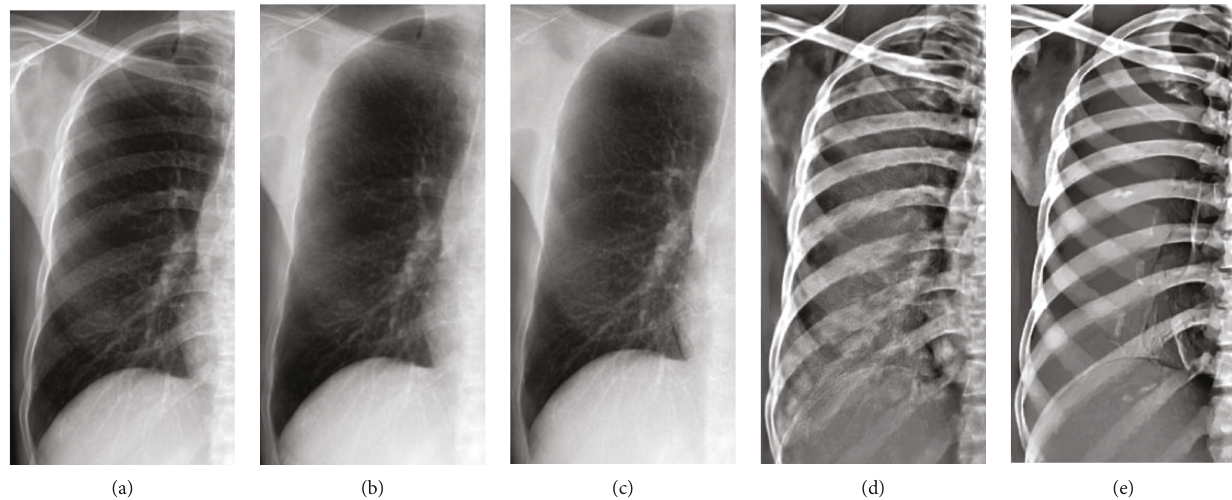
Figure 7: Decomposition results of a chest radiograph without motion artifacts: (a) the right lung fi eld of a chest radiograph; (b) the decomposed soft tissue image; (c) the actual DES soft tissue image; (d) the decomposed bone image; (e) the actual DES bone image.